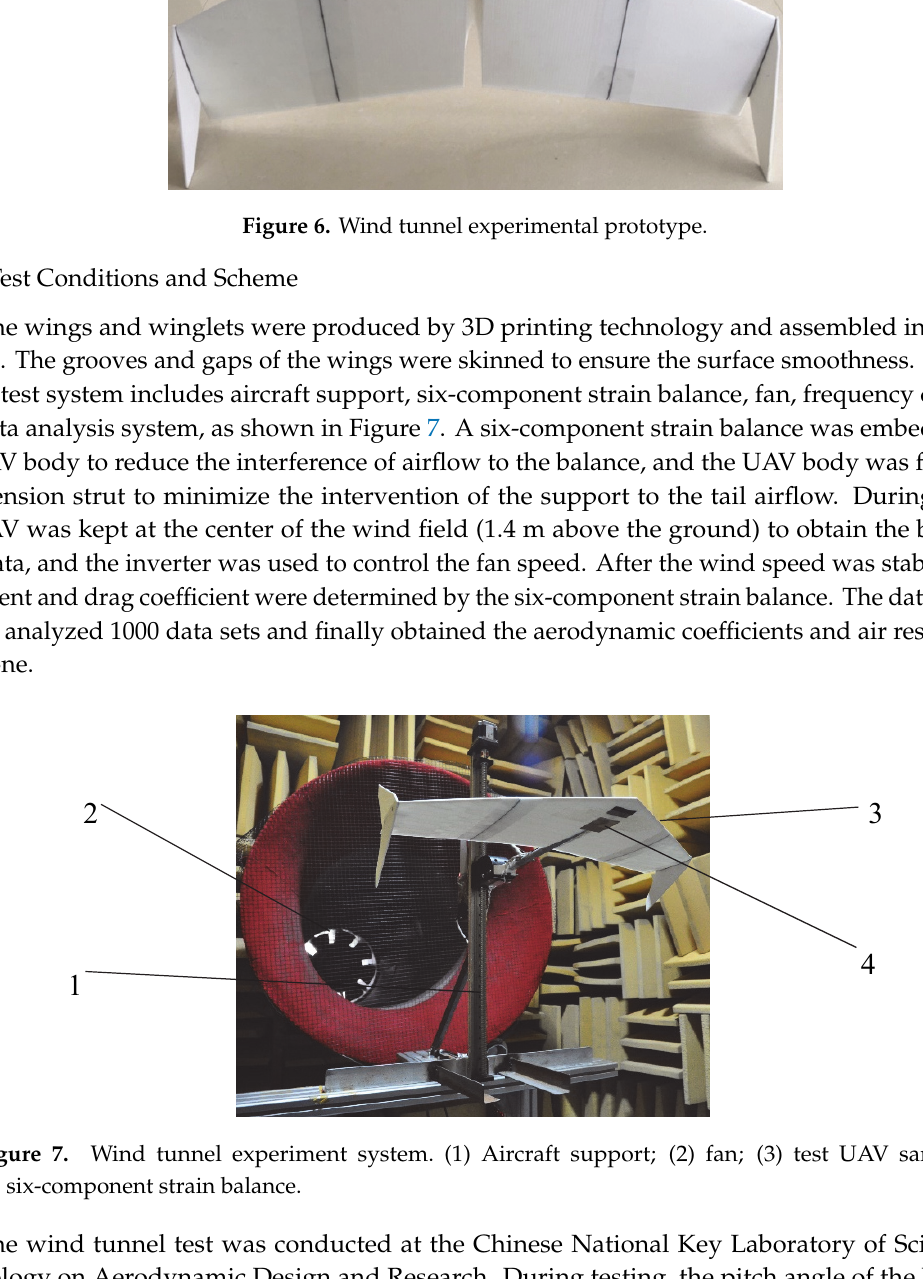
Figure 8. Wind tunnel test results. The average error of the aerodynamic coefficient C FA was less than 5%, while the air resistance D less than 6%. Since the UAV model was constructed using 3D printing, the surface roughness 0.20.4 0.60.81.01.2 1.4 02 46810 12 350000